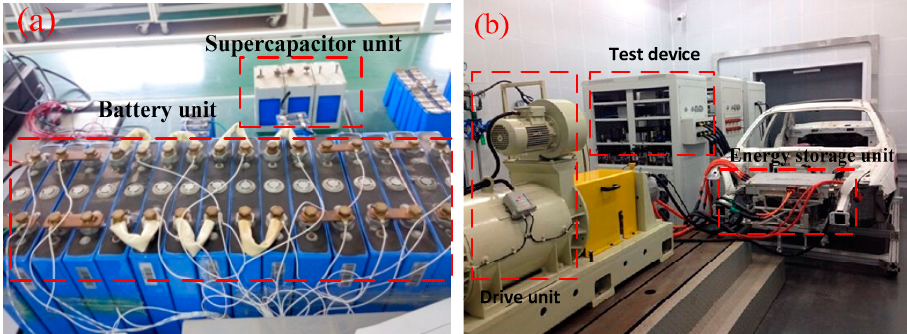
Figure 6. Experimental test device: ( a ) Mixed energy storage unit; ( b ) Vehicle test device.